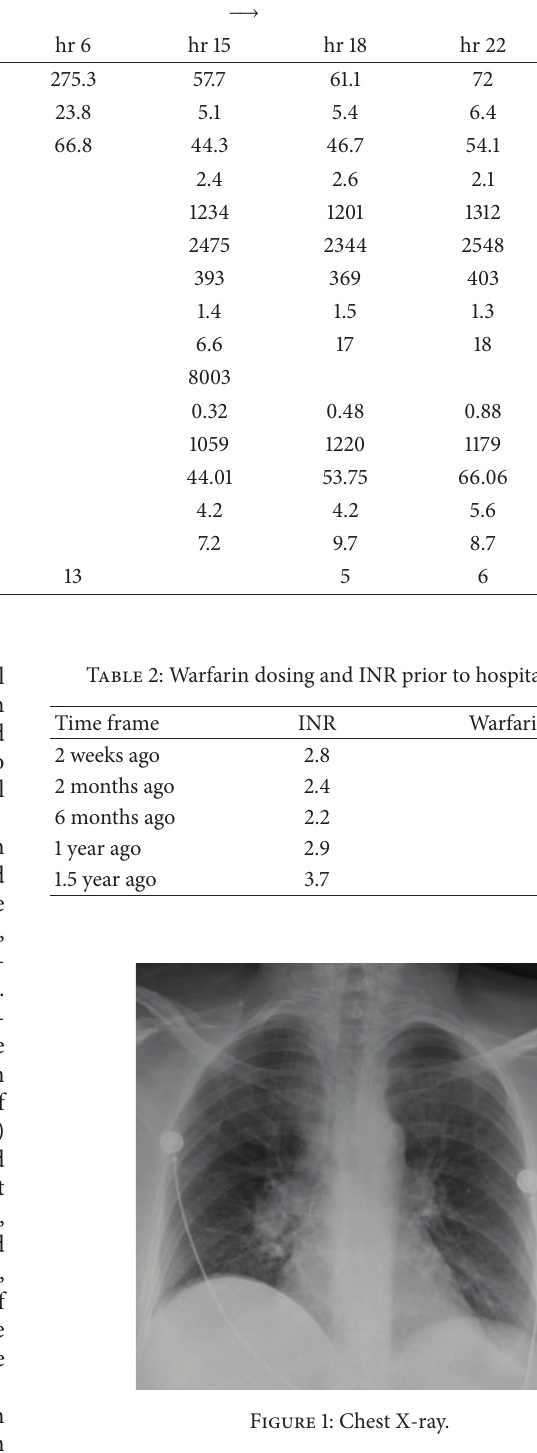
Table 1: Patient’s laboratory values during hospitalization until death.